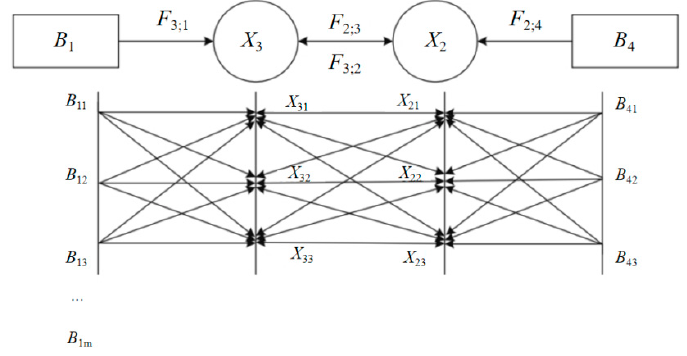
Figure 2. Example of a typical PUL ‐ DUCG model.